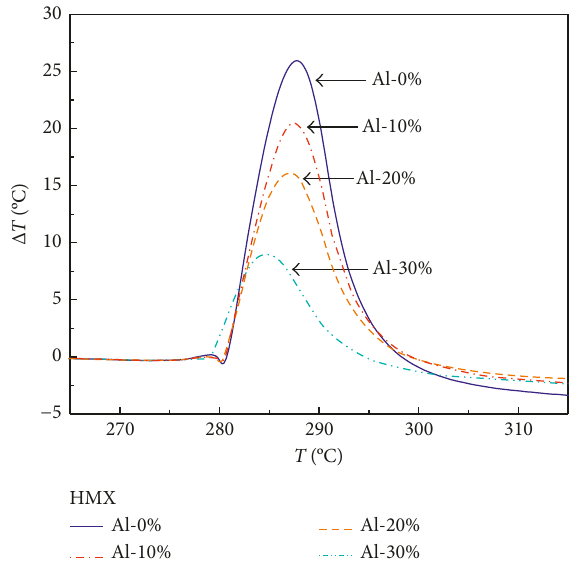
Figure 6: DTA curves of HMX with different mass percentages of Al powder.